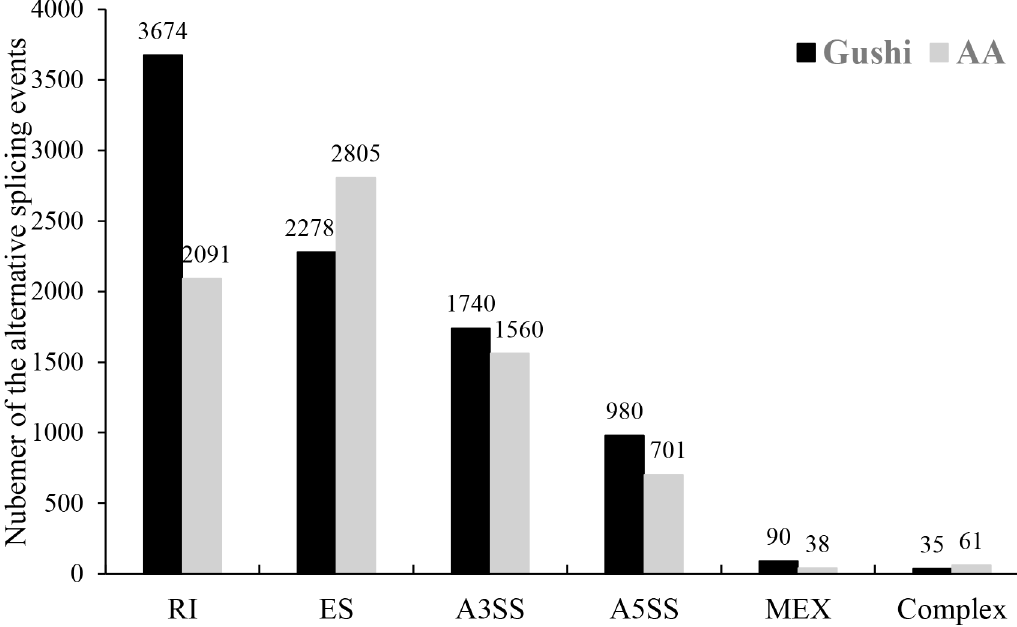
Fig 7. Schematic representation of the alternative splicing events in the samples. The y-valuerepresents the number of observedsplicingevents, and the x-valueshows the major six alternative splicing types in Gushi chickens and AA chickens, respectively. RI = retainedintrons; ES = exon skipping;A3SS = alternative 3’ splicingsites; A5SS = alternative 5’ splicing sites; MEX = mutually exclusive exons.